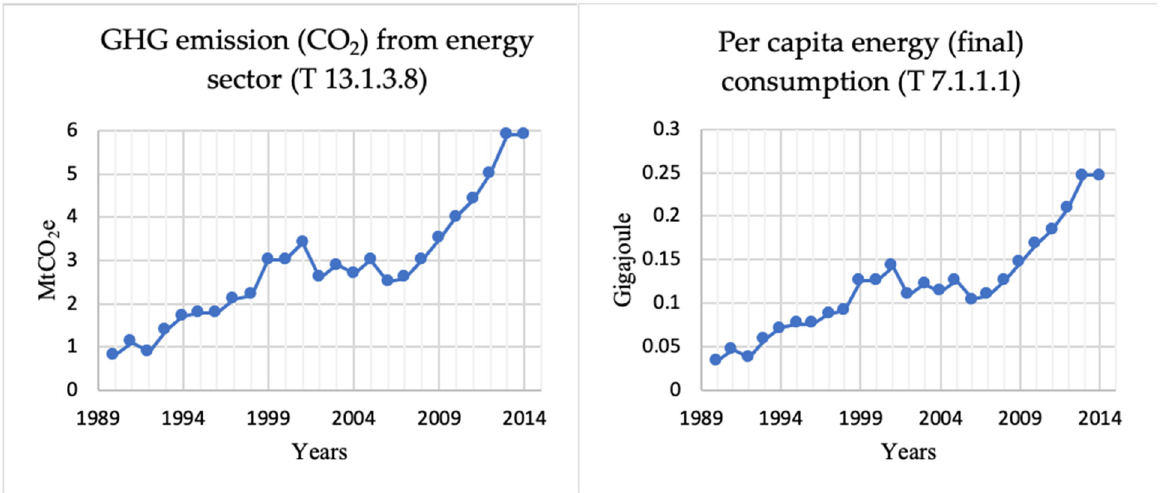
Figure 9. GHG emission (CO 2 ) from energy sector ( left ) and per capita energy (final) consumption ( right ).